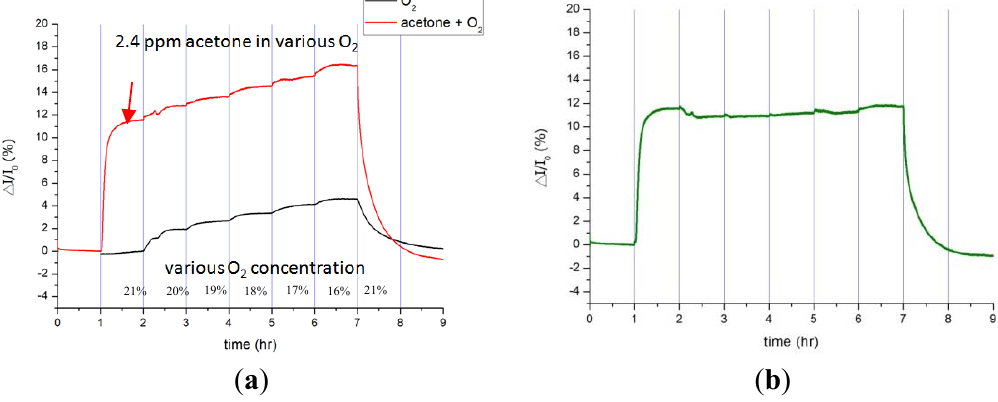
Figure 6. Effect of oxygen on acetone detection using the Pt-InN sensor under various oxygen concentrations of 21% to 16% ( a ) pure oxygen (red line) and oxygen with 2.4 ppm acetone (black line); ( b ) the sensor exposed to constant 2.4 ppm